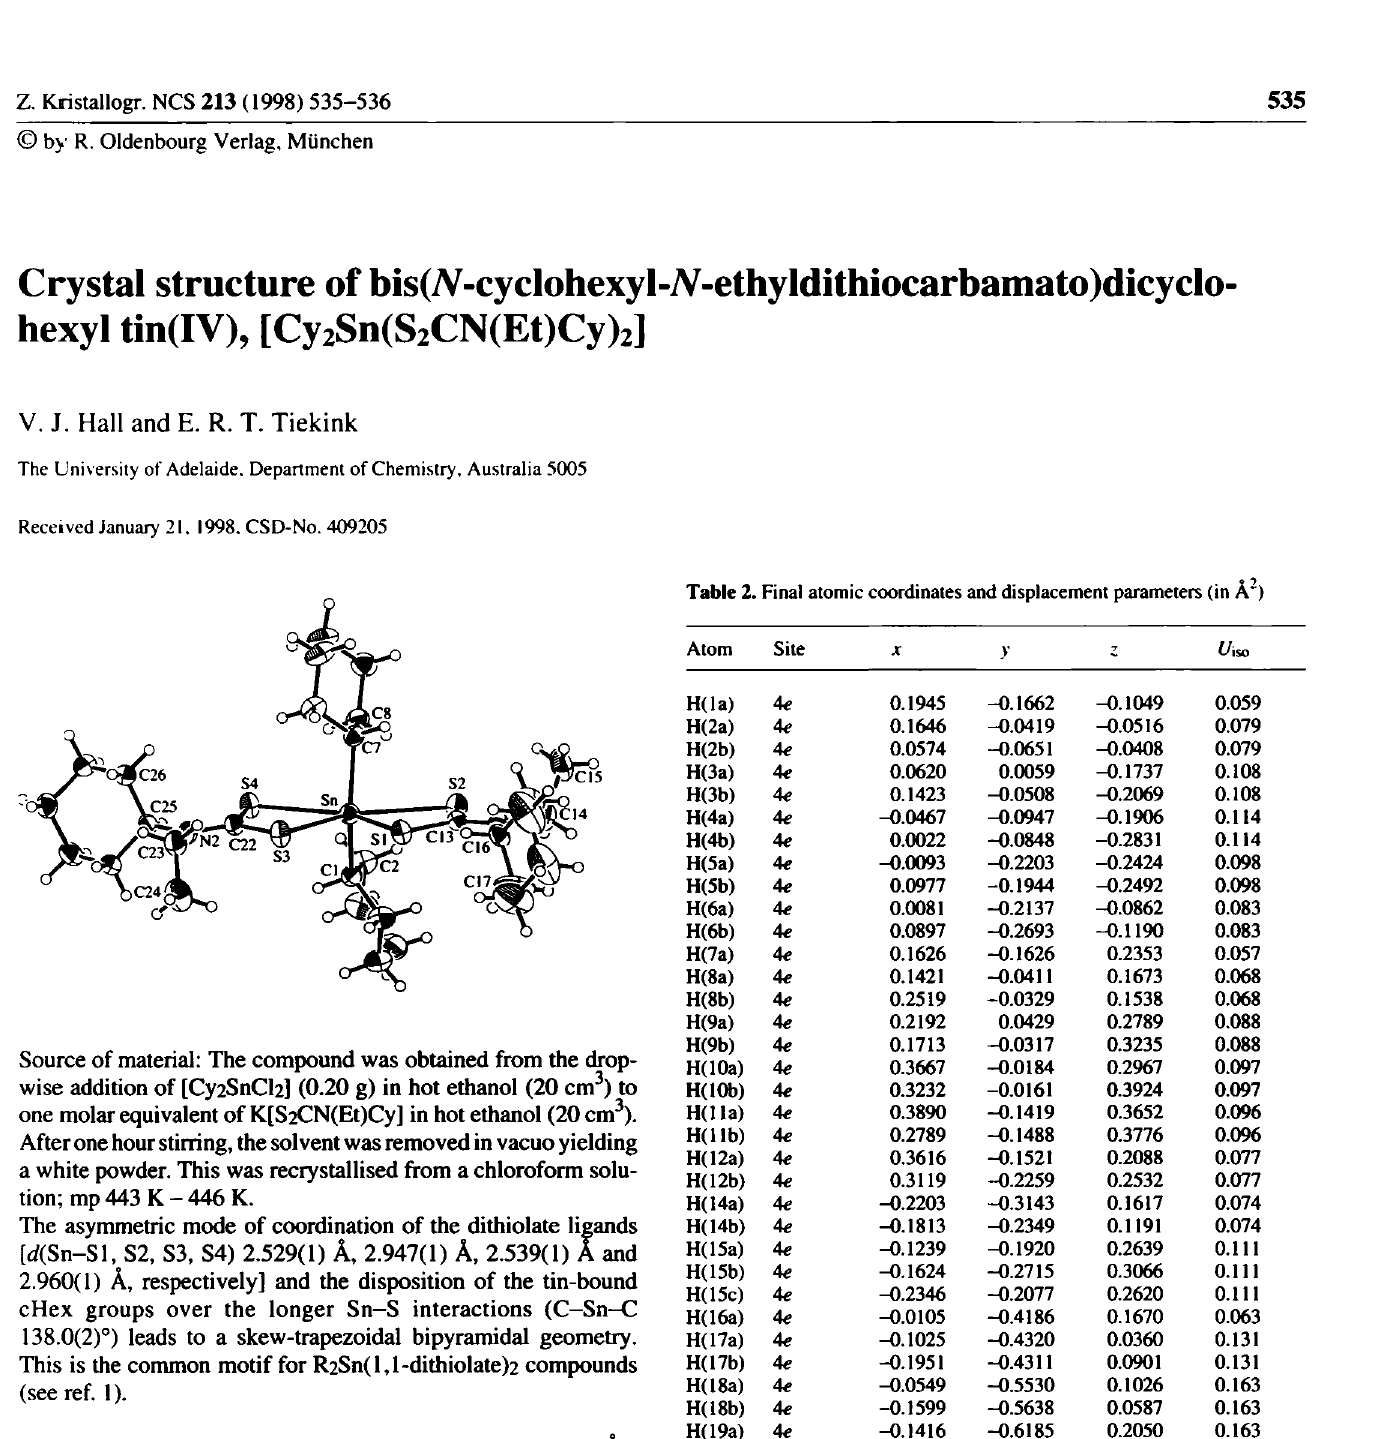
Table 1. Parameters used for the X-ray data collection Crystal: